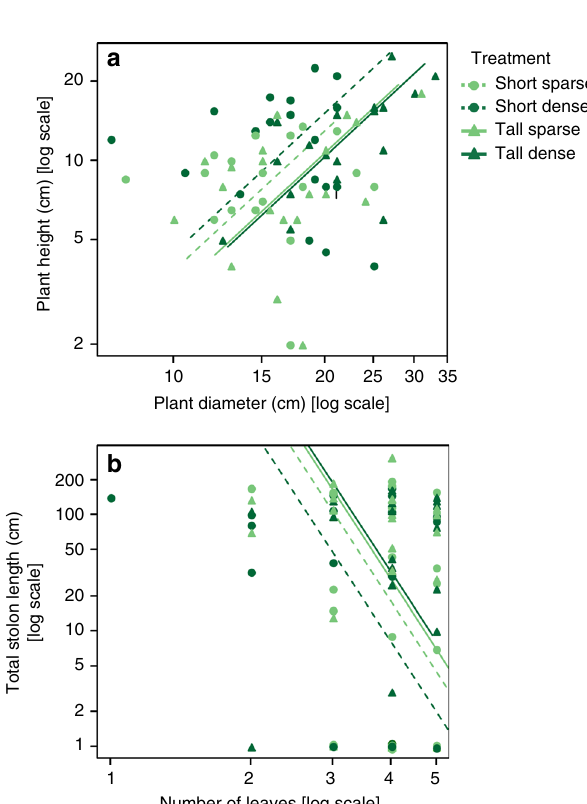
Fig. 3 Treatment effects on the allometric relationships between plant traits. Standardised major axis (SMA) relationships between plant height and diameter ( a , n = 19) and between total stolon length and number of leaves ( b , n = 20) within the short (circles and dashed lines), tall (triangles and solid lines) sparse (bright green) and dense (dark green) treatments (see Table 2 for further